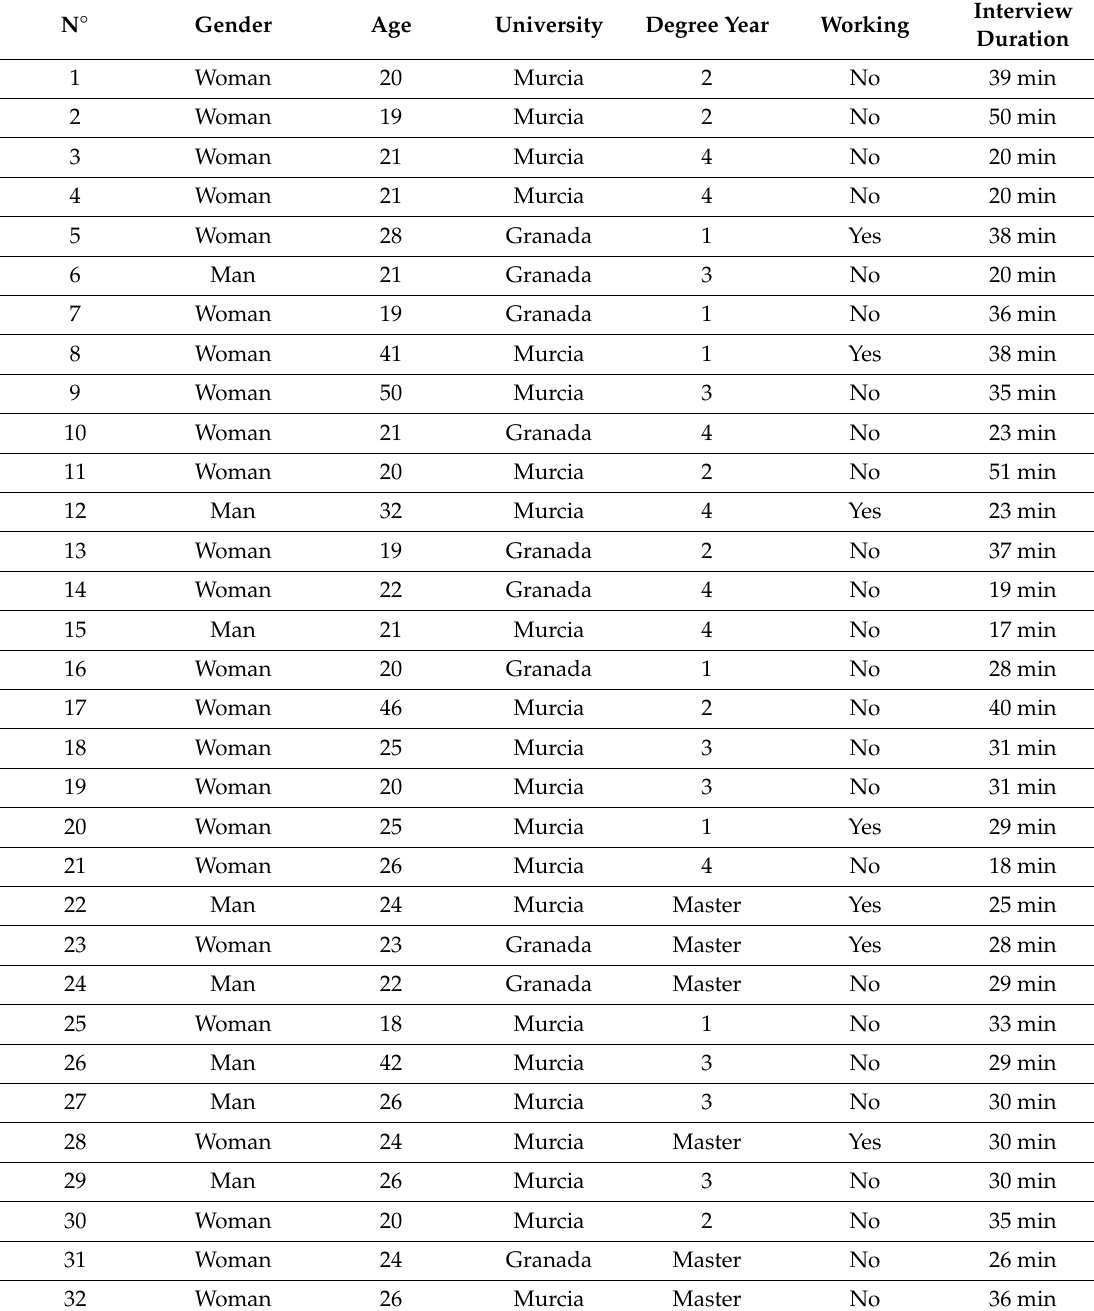
Table 1. Characteristics of the participants and duration of the